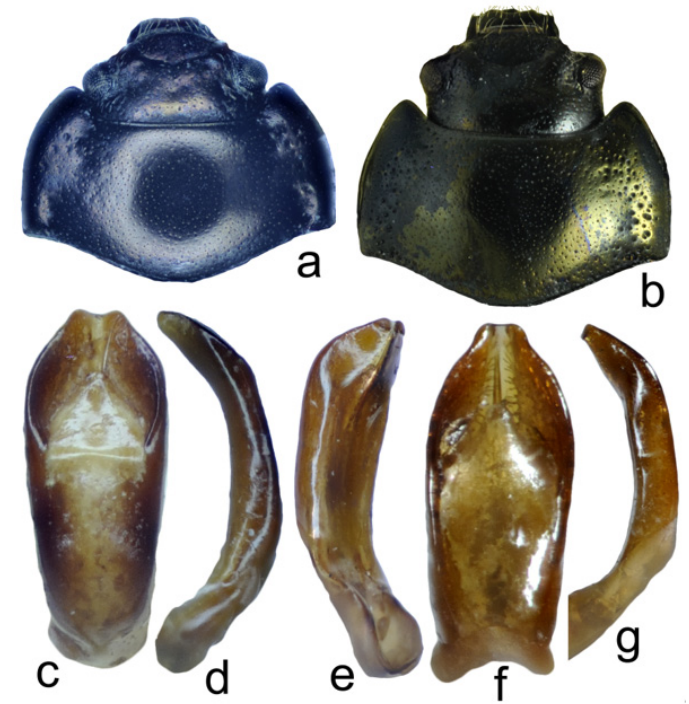
Figure 8. Chrysolina , structural details: ( a ) Ch. fascinatrix , holotype, male, head and pronotum; ( b ) Ch. wangi , holotype, male, head and pronotum; ( c ) Ch. fascinatrix, holotype, male, aedeagus, dorsal view; ( d ) the same, lateral view; ( e ) Ch. wangi , holotype, male, aedeagus, latero-ventral view; ( f ) the same, dorsal view; ( g ) the same, lateral view.